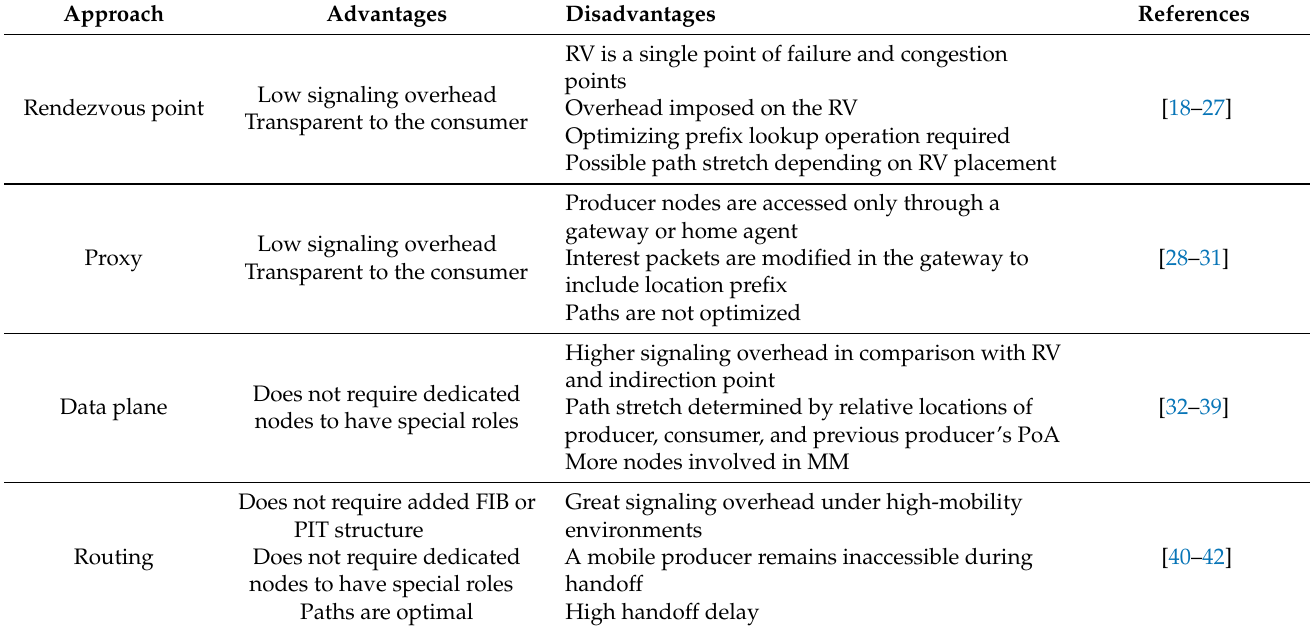
Table 1. Advantages and disadvantages of producer MM